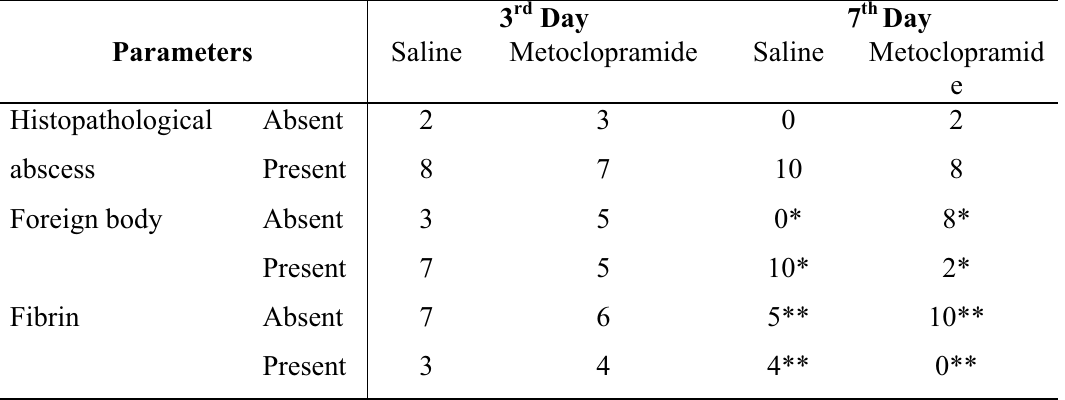
TABLE 6 - Number of animals by histopathological parameters divided in which group